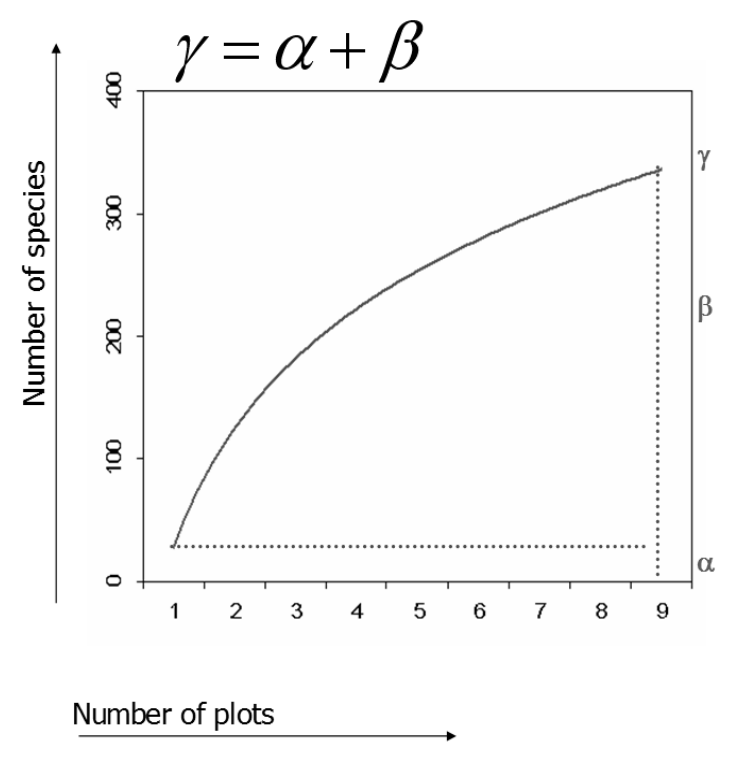
Figure 1. Additive partitioning of diversity.  -diversity is represented by the sum between  and  . This leads to consider  in the same unit of measurement (i.e. number of species) of  and